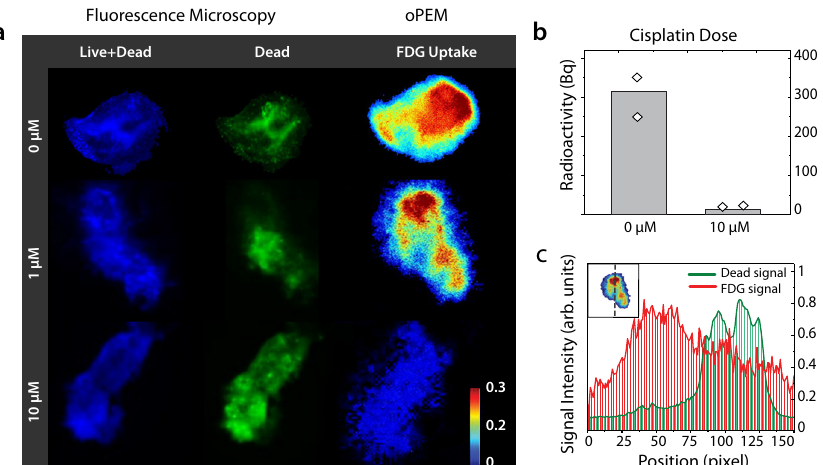
Fig. 5 oPEM & fl uorescence co-imaging of metabolic activity after cisplatin treatment. a Untreated organoid shows a spatial pattern of cellular viability ( fl uorescence stain; left column) consistent with the FDG uptake pro fi le (right column). Organoids treated with increasing doses of cisplatin experience a decrease in their metabolic activity. Blue: Hoechst 33342 (all nuclei), Green: SYTOX green (dead nuclei). The color bar shows radioactivity (Bq/pixel). b Quantitative FDG uptake inside tumor organoids treated with 0 or 10 µ M dose of cisplatin ( n = 2 organoids from two independent experiments). c The intensity pro fi le of the FDG signal and green channel along the dotted line (inset) shows a spatial